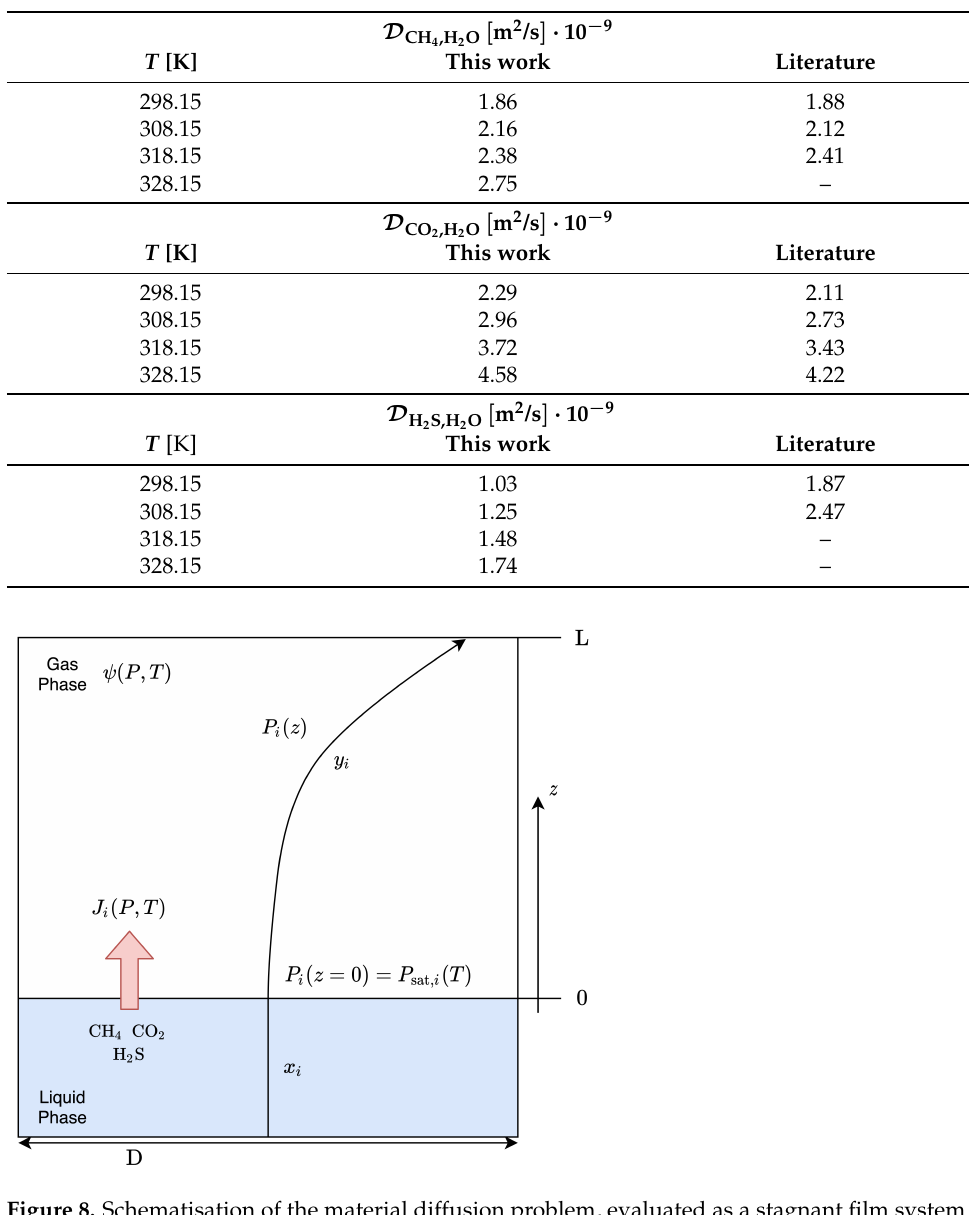
Table 4. Comparison between diffusivities found in the literature and predictions provided by this work.